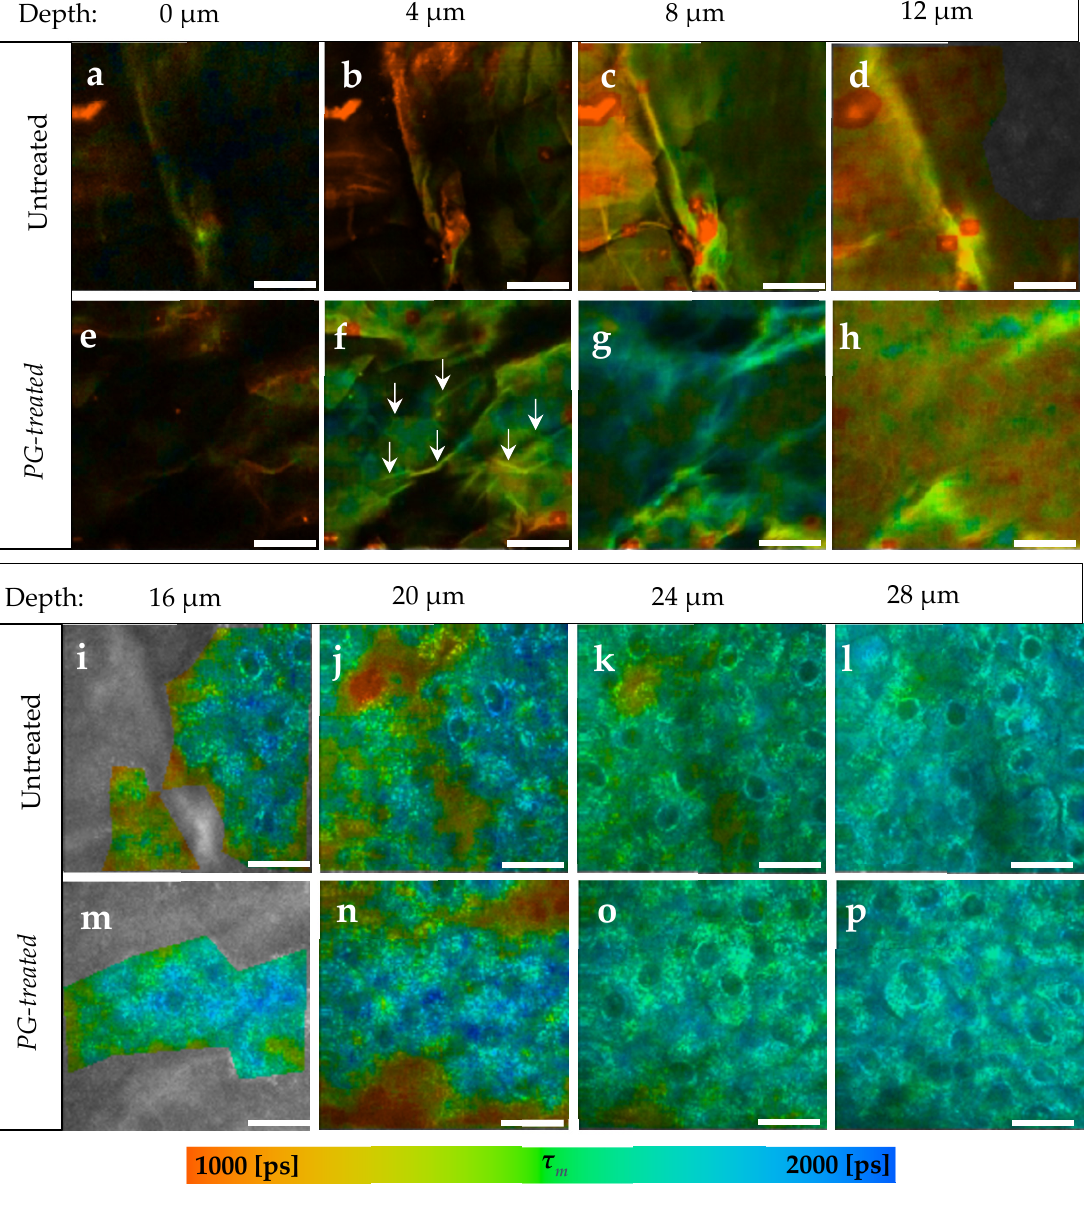
Figure 1. TPE-FLIM images depending on skin depth of PG -treated compared to untreated skin. ( a – d ) The SC of untreated skin sample; ( e – h ) The SC of PG -treated skin sample; ( f ) arrows refer to lines, which are assumed to be the areas between the corneocytes; ( i – l ) The viable epidermis of untreated skin. ( m – p ) The viable epidermis of PG -treated skin. In both samples there was